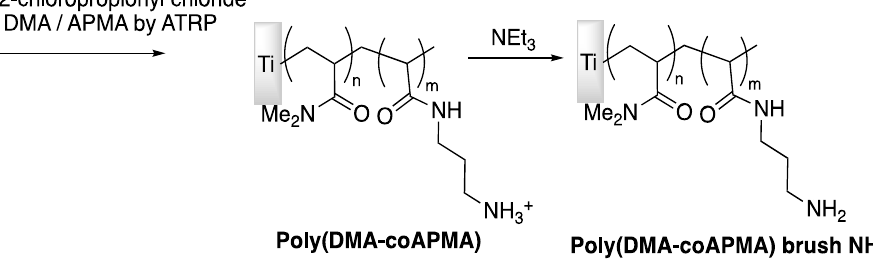
Figure 9. Synthetic route for copolymer brushes generation on titanium surface.